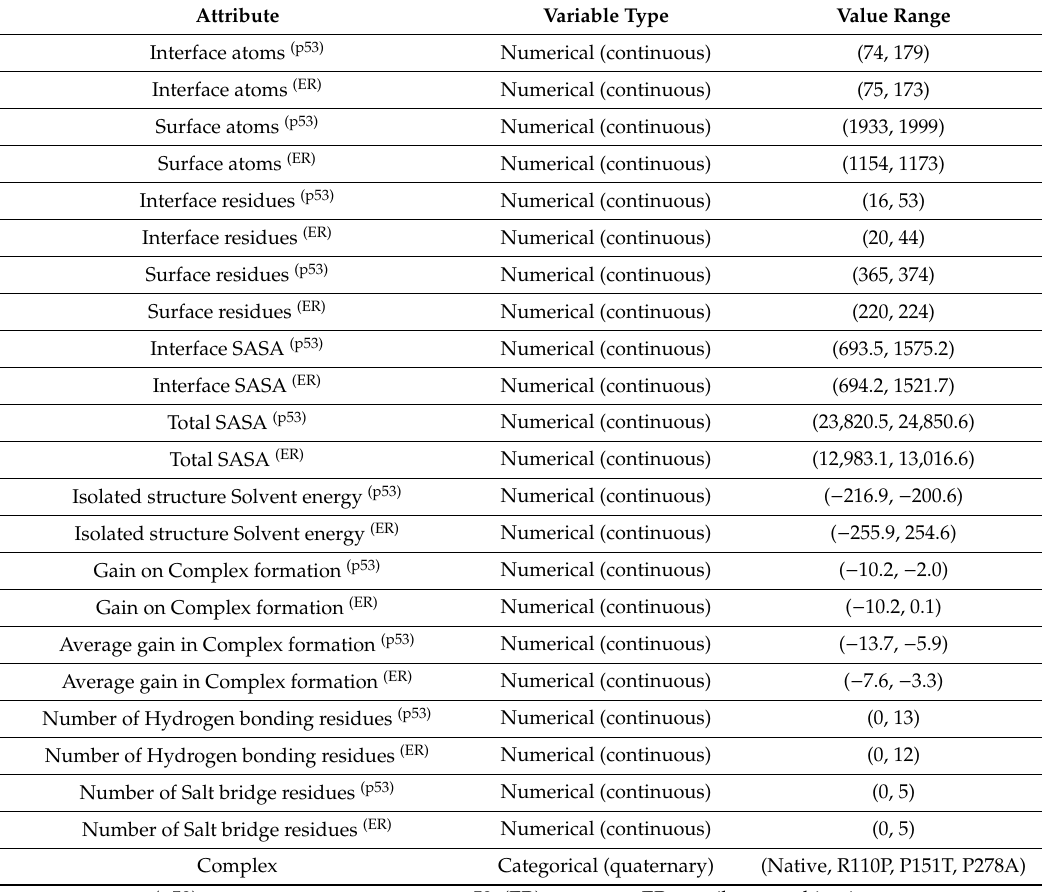
Table 2. Attributes used for building the neural network for p53–ER α interaction.